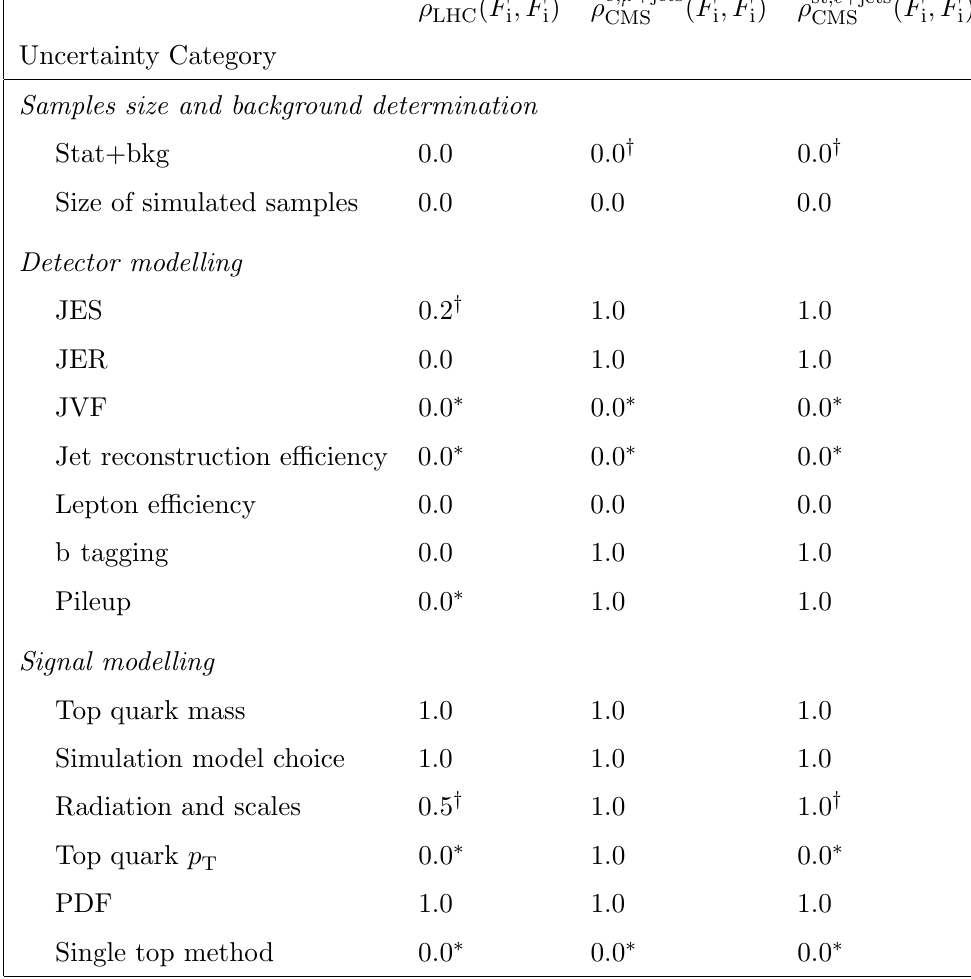
Table 6 . Input correlations across di(cid:11)erent measurements, as explained in section 4.1. The values stand for the correlations (cid:26) ( F are assumed to be (cid:26) ( F the correlation value is set to zero and marked with an asterisk. The correlations marked with a dagger sign are those that are not precisely determined and checks are performed to test the stability of the results against these